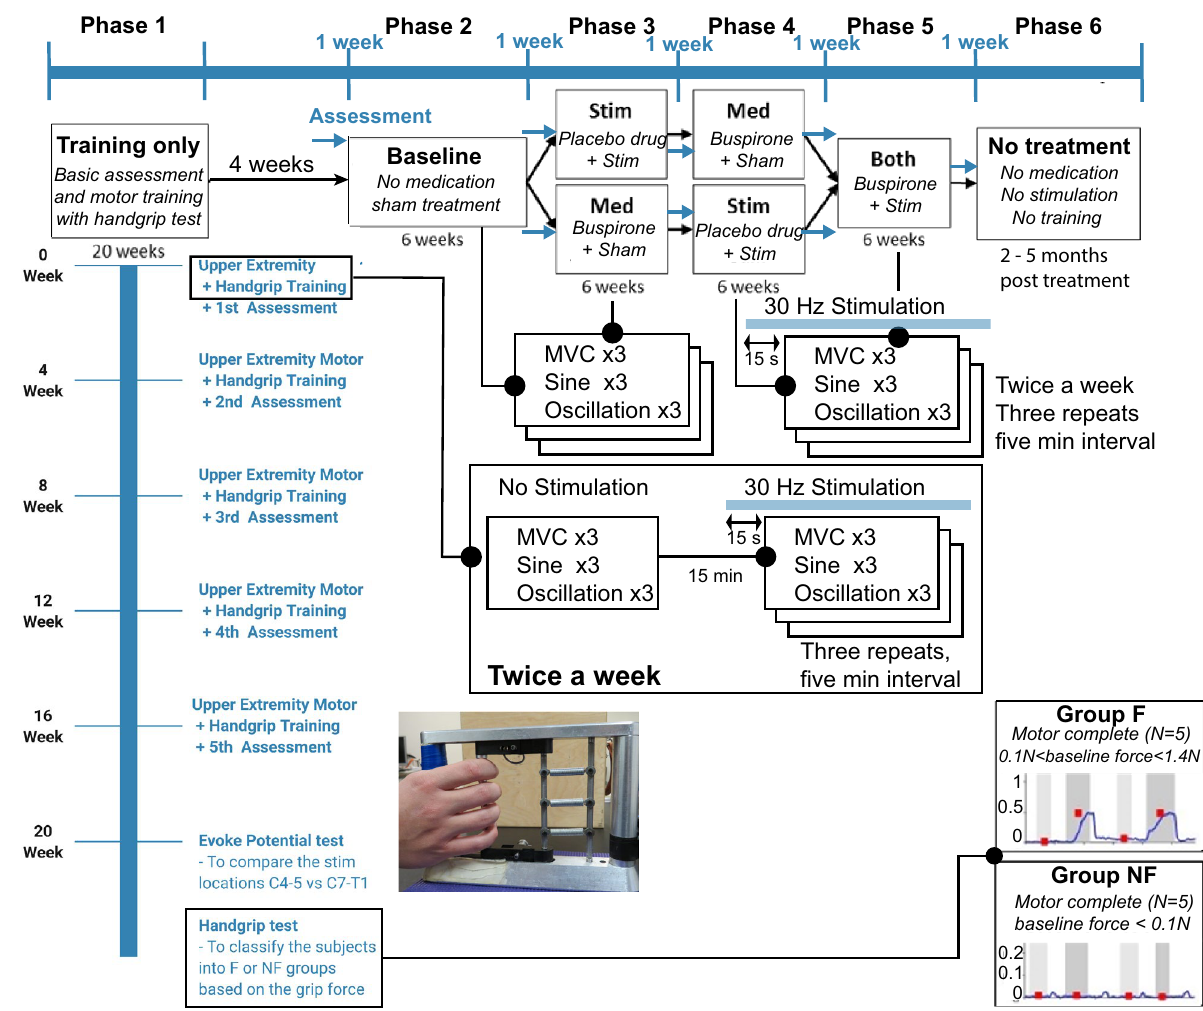
Figure 1. Overview of study design and tasks performed. A single population of subjects was recruited from a prior study that assessed the effect of handgrip training alone 10,26 . Within the recruited population, two groups were defined: one group of subjects had no hand strength (Group NF; < 0.1 N grip force) and the other population had minimal (> 0.1 N and < 1.4 N) grip force (Group F). The study was broken into six phases as shown above. At the time of enrollment, all subjects underwent baseline physiological assessments to map evoked responses from the spinal cord. The blue arrow indicates the 1-week functional assessment between the four treatment phases as well as before the Baseline (Sham only) and after the Both (buspirone + Stim)